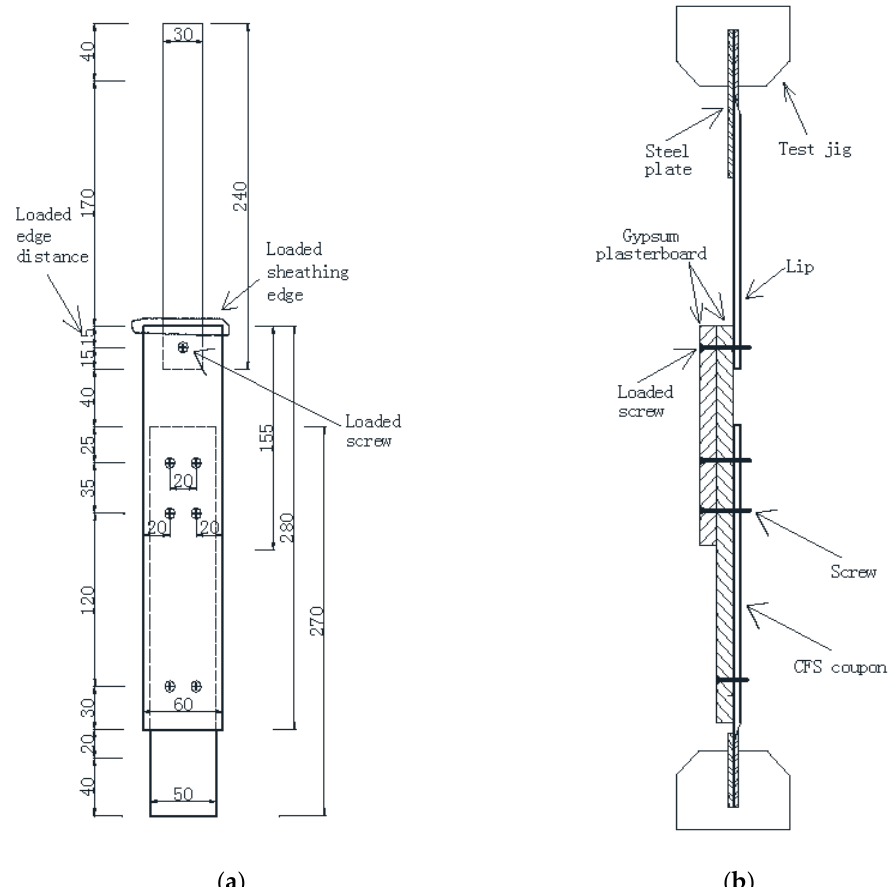
Figure 3. Connection details with single ‐ layer sheathing and a loaded edge distance of 15 mm: ( a ) front view; and ( b ) side view.